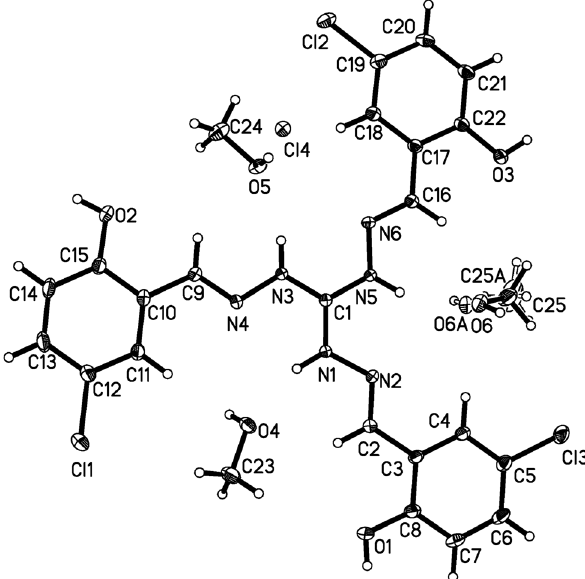
Table 1 contains crystallographic data and Table 2 contains the list of the atoms including atomic coordinates and displacement parameters.